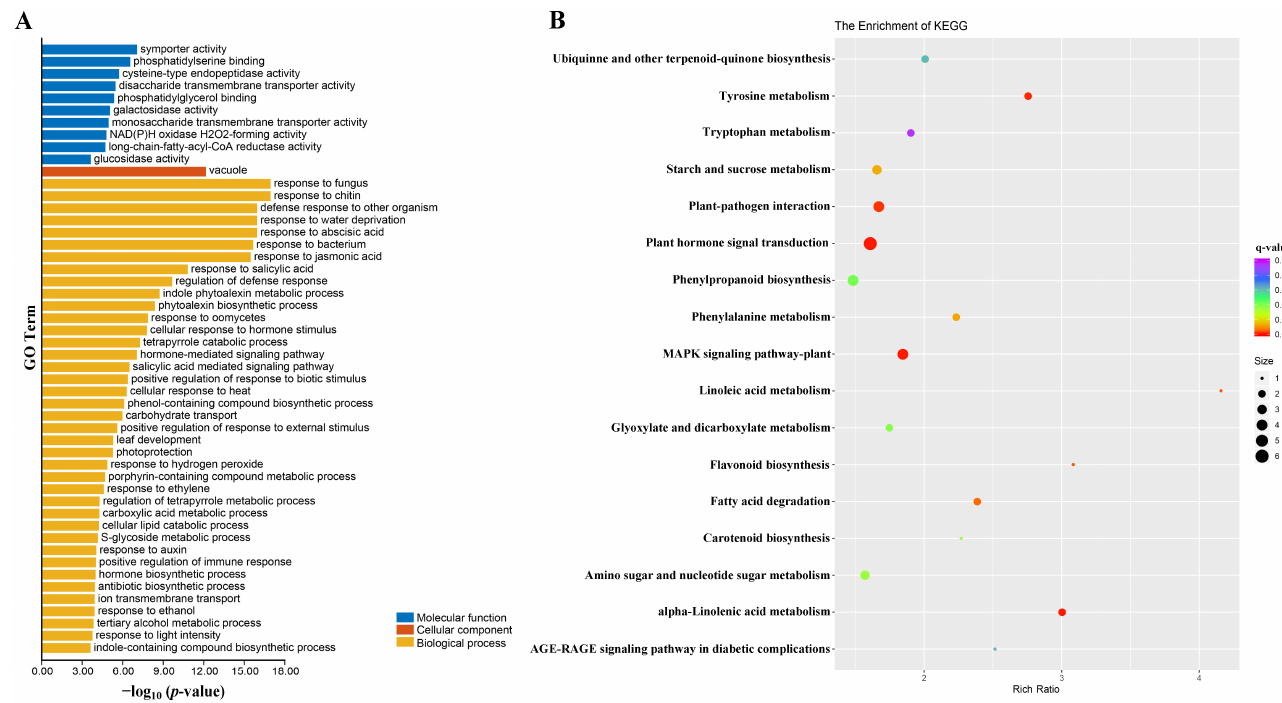
Figure 5. Functional analysis of DEGs (differentially expressed genes). ( A ) The top-50 enriched GO terms in molecular function, cellular component, and biological process categories. ( B ) KEGG pathway enrichment of the DEGs. The circles’ size is proportional to the number of genes, and their color denotes the range of the q-value.